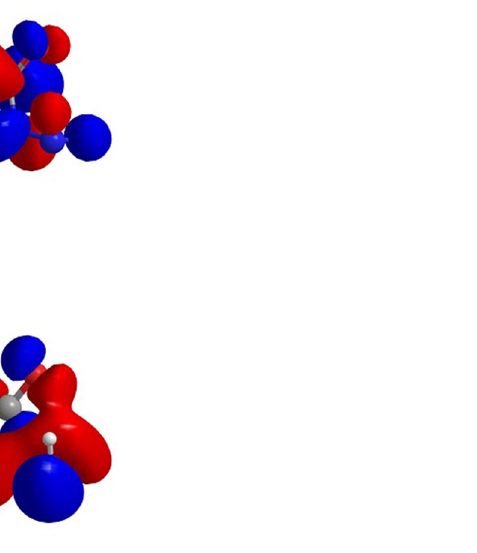
Figure 16. Inhibitor energy diagram HOMO and LUMO